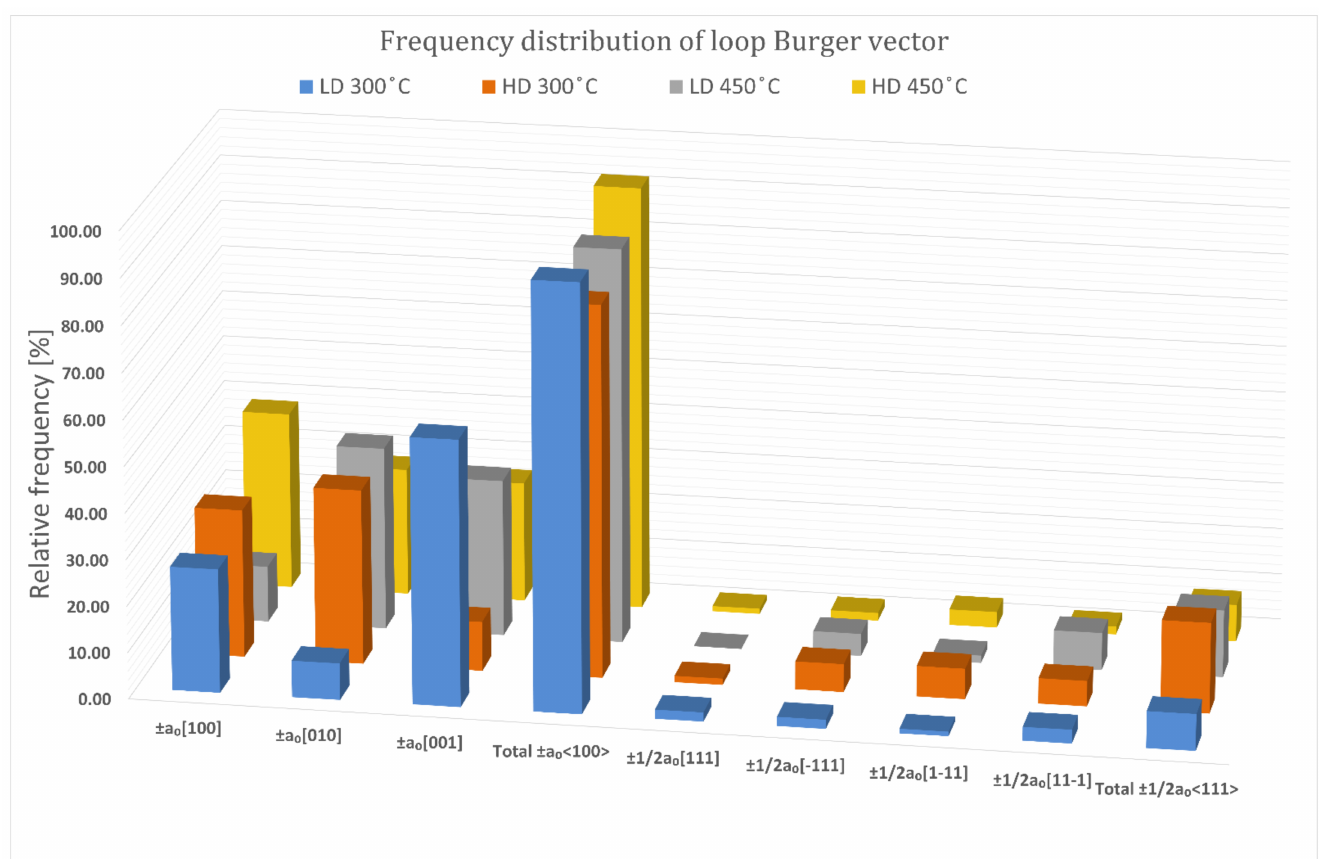
Figure 22. Frequency distribution of Burger vector of the dislocation loops observed in all